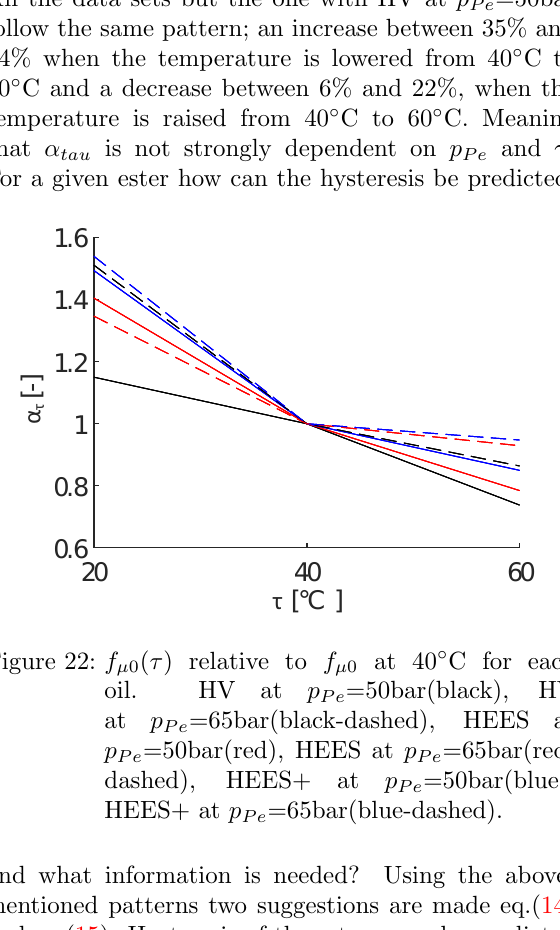
Figure 23: f µ 0 ( τ ) vs predicted f µ 0 *( τ )(dashed) using 15 for the two esters. HEES at p Pe =50bar(black), HEES at p Pe =65bar(blue), HEES+ at p Pe =50bar(red), HEES+ at p Pe